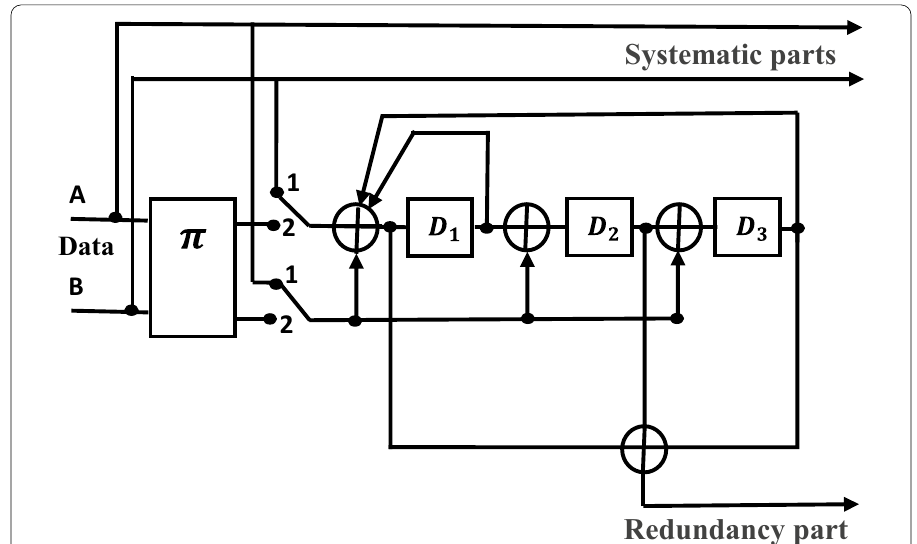
Fig. 2 Duo binary turbo code (DBTC). The 8-state duo binary turbo code used in the present